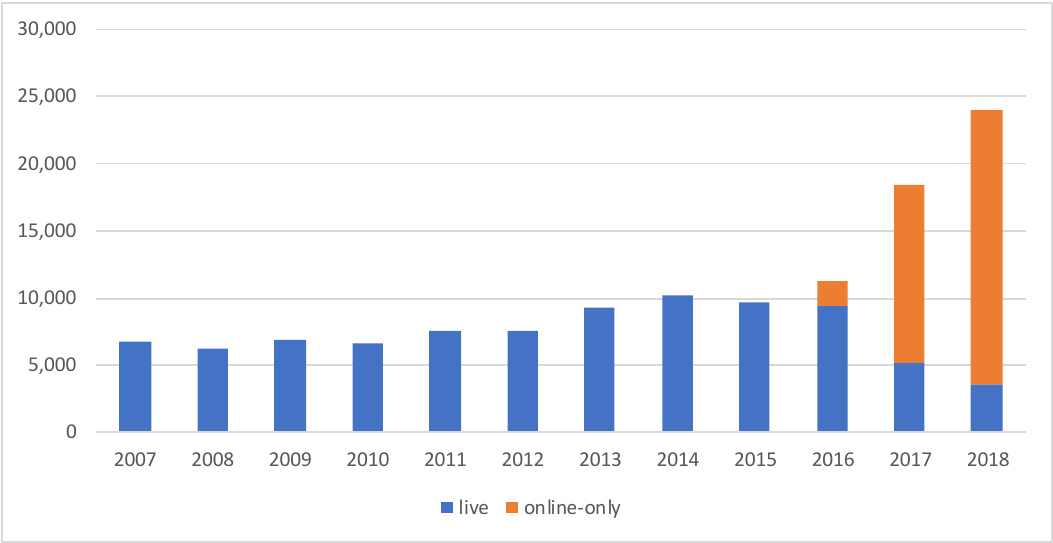
Figure 5. CML’s turnover with the contribution of online -only auctions (2007 – 2018).